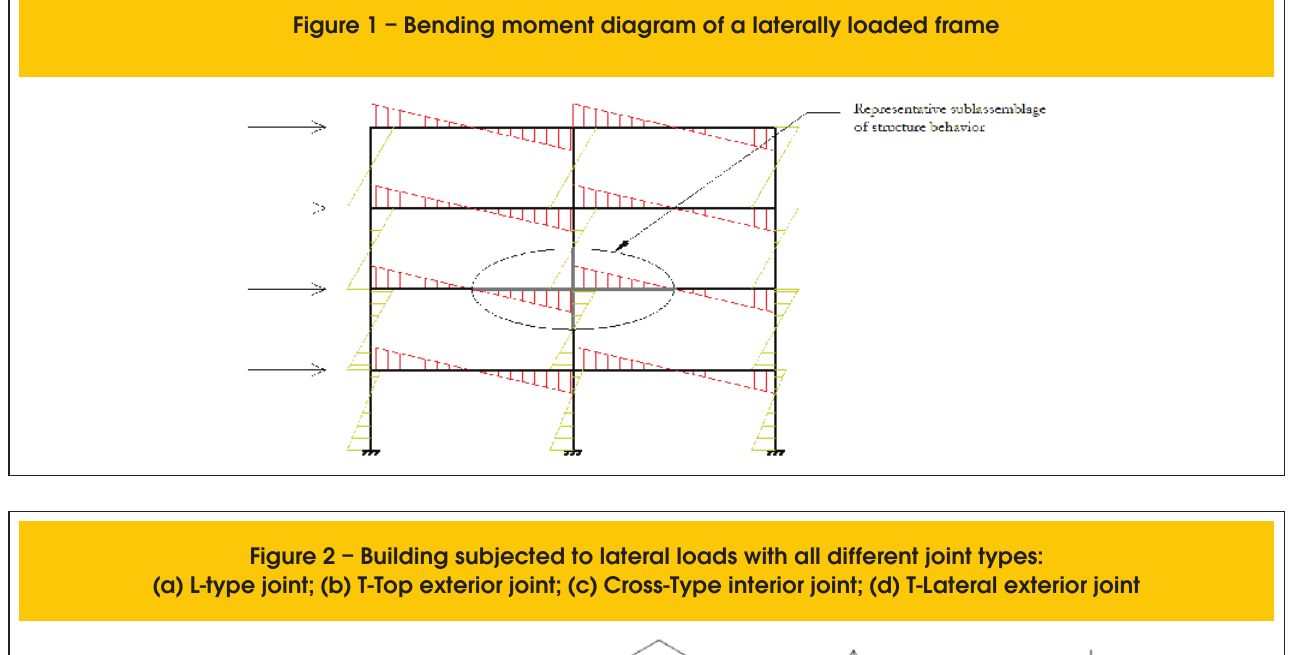
Figure 1 – Bending moment diagram of a laterally loaded frame